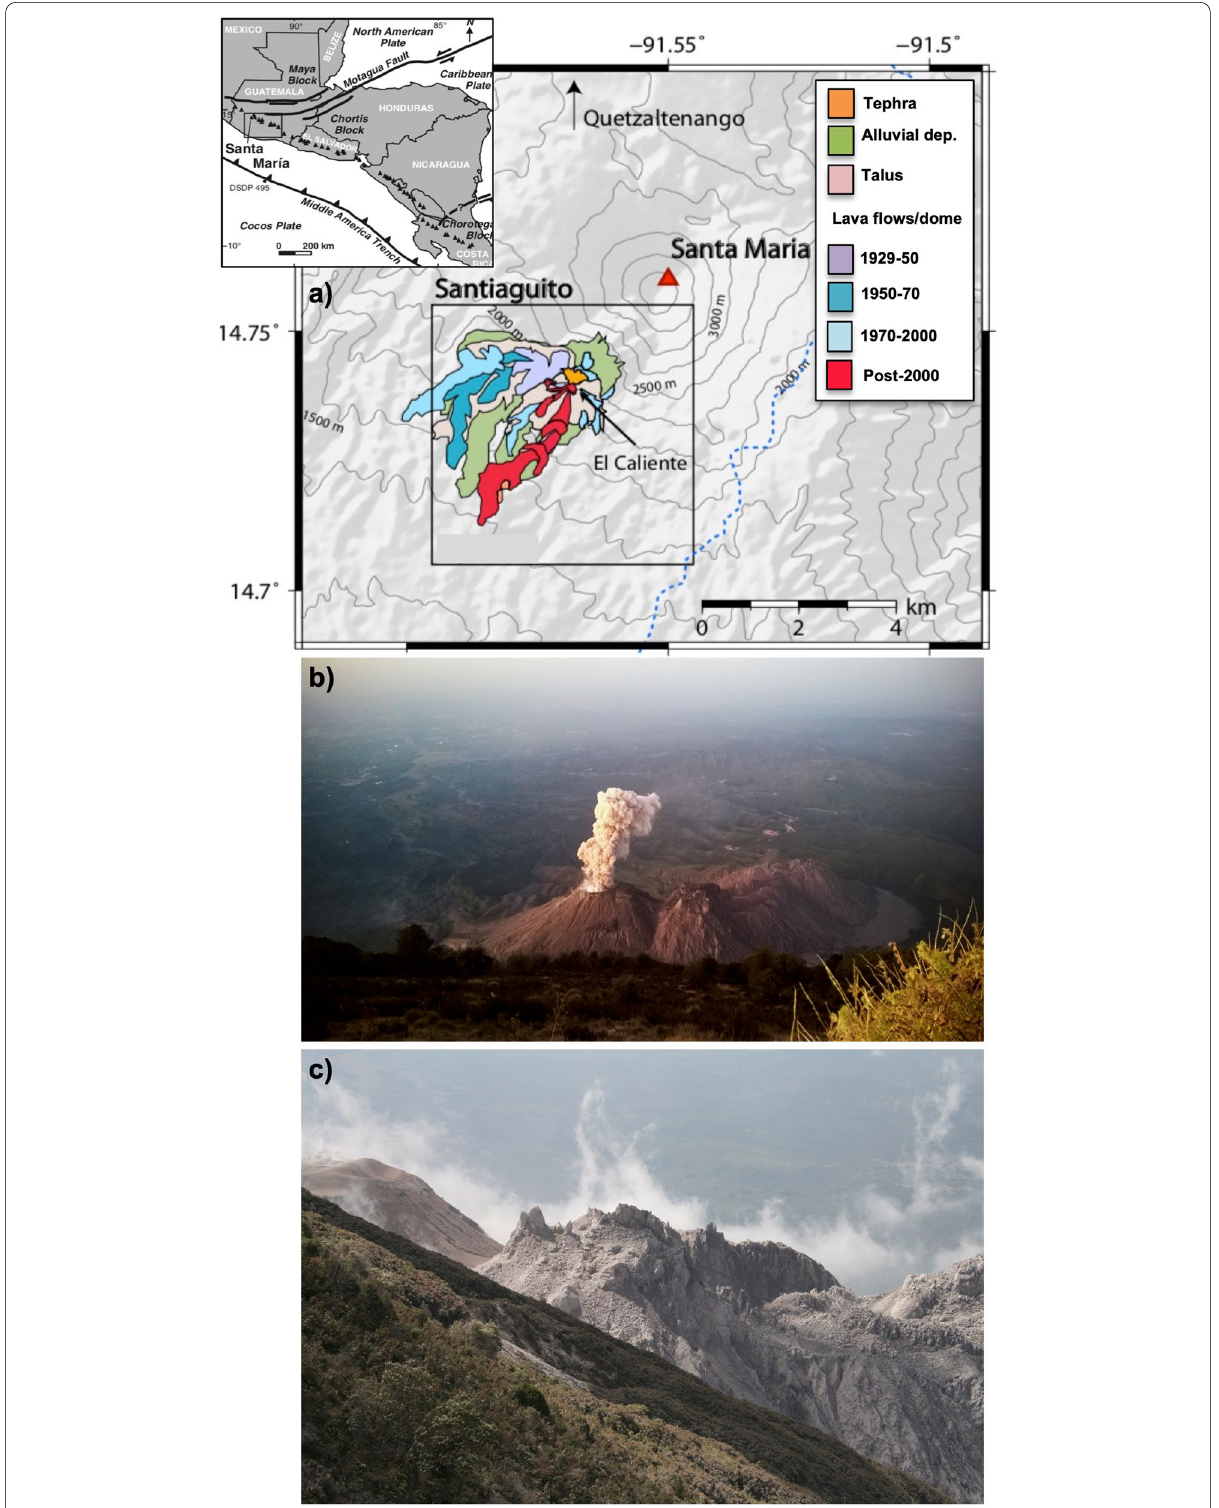
Fig. 1 a Map of the Santiaguito lava dome complex showing the location and the geological units ( modified from Ebmeier et al. 2012). In the inset the tectonic setting of Santa Maria volcano modified from Singer et al. (2011); b explosive activity from El Caliente (courtesy of Alana Weir); c particular of the structure of the lava dome (credit by Wikimedia